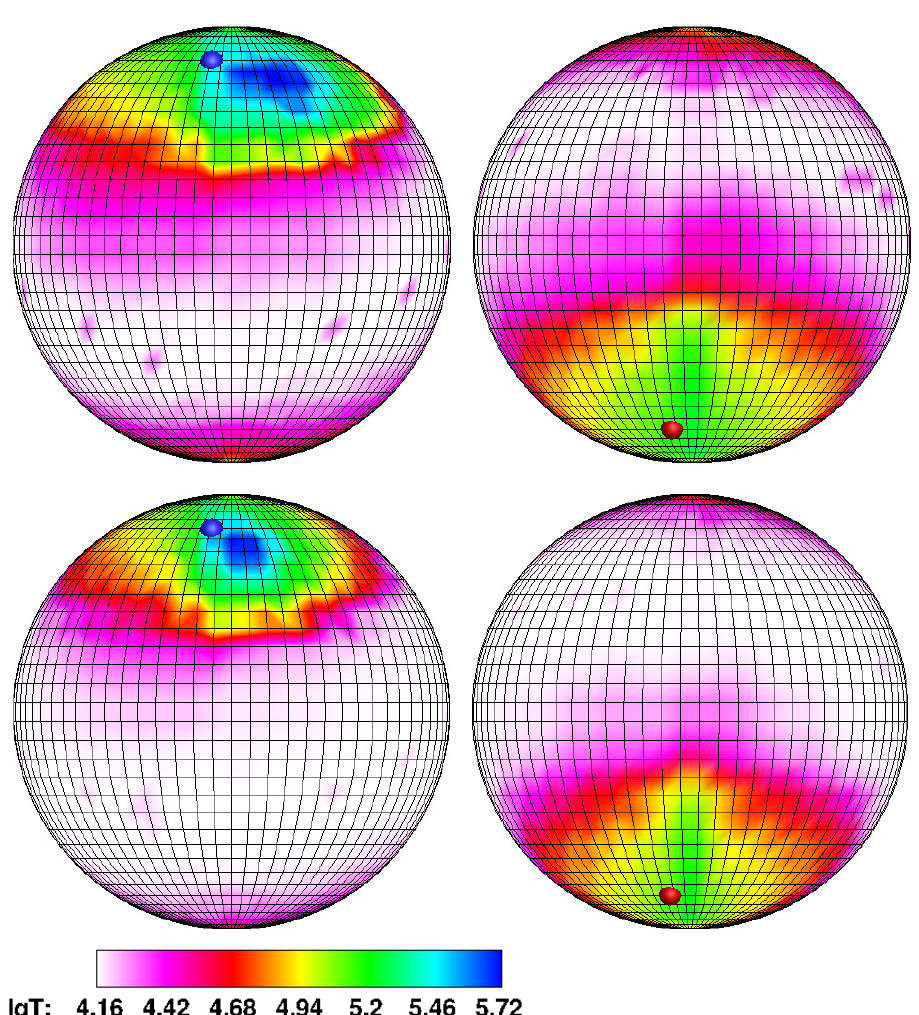
Figure 4. Temperature distribution over the accretor surface for Model 1 ( upper panel) and Model 2 ( lower panel). The left hemisphere corresponds to the side of the accretor facing the donor; the right hemisphere corresponds to the opposite side of the accretor. The symbols on the surface of the accretor indicate the positions of the north (blue) and south (red) magnetic poles, taking into account the orientation of the magnetic dipole relative to the